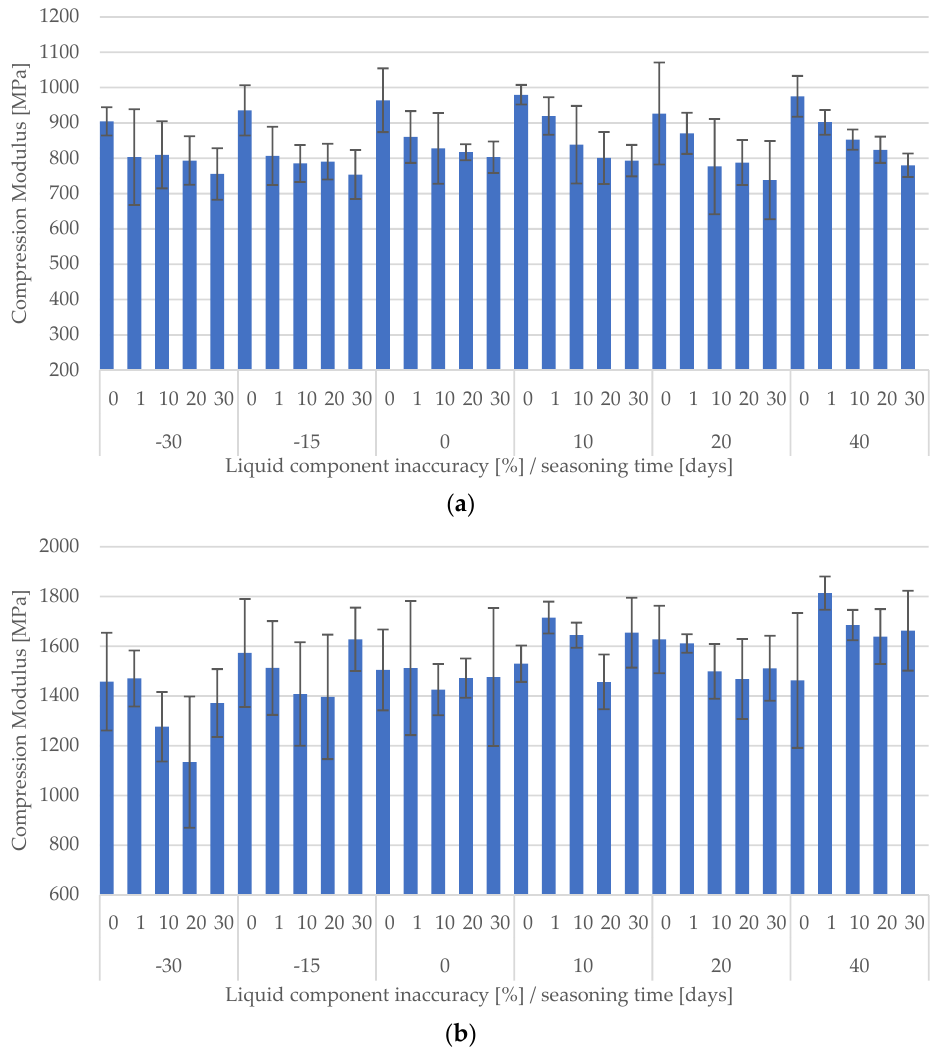
Figure 8. Summary results of the compressive modulus of the tested cements depending on the seasoning time ( a ) CMW 3 Gantamicin, ( b )